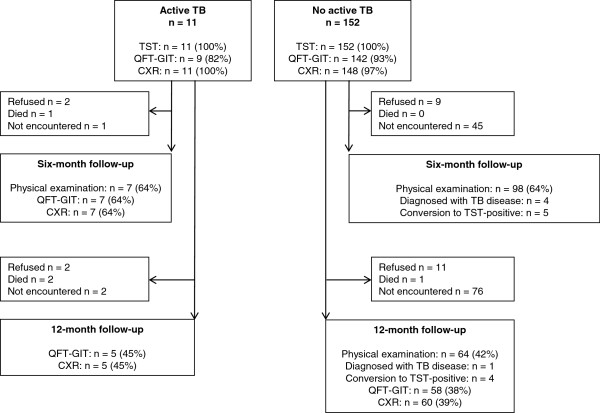
Study recruitment profile and number of children assessed at different time points.